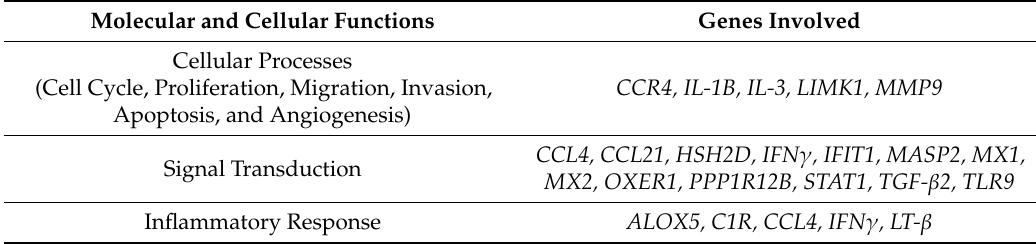
Table 2. Genes based on their functional annotations.